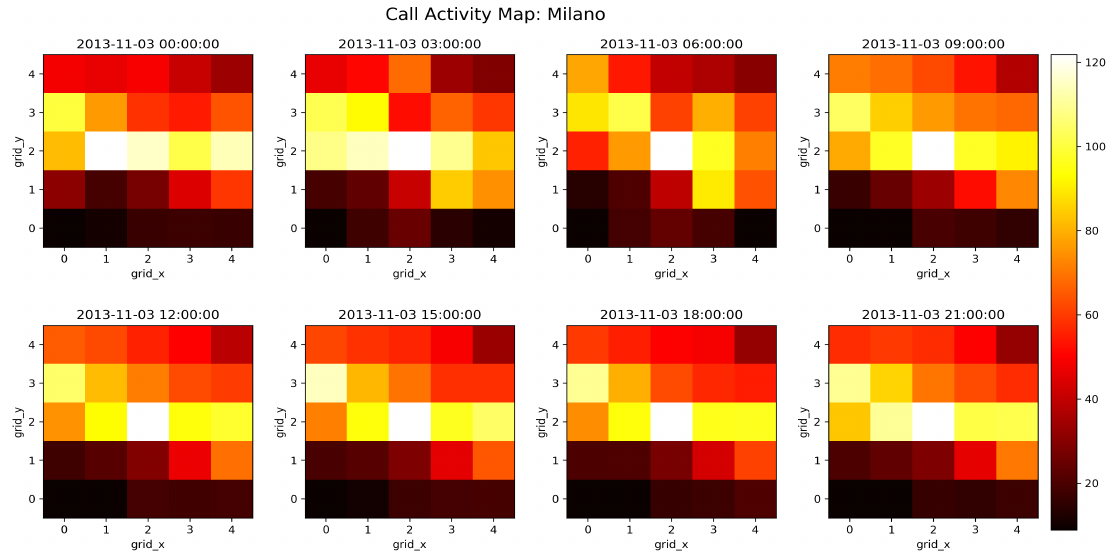
Figure 6. Spatial Variation of CDR activities over the City of Milan for one day’s Time